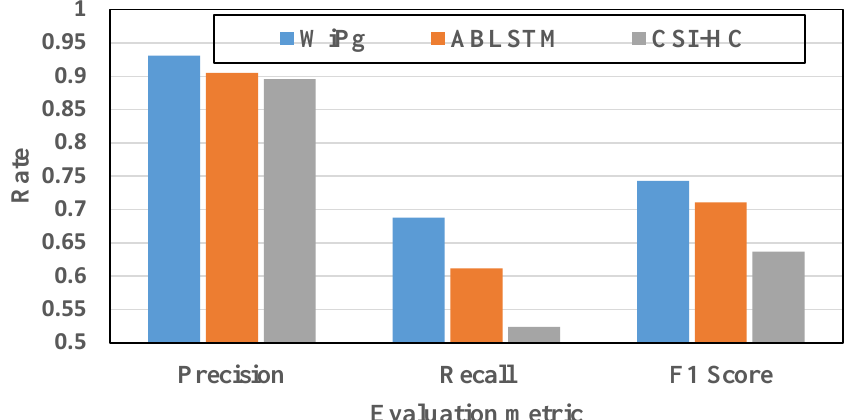
Figure 19. Comprehensive evaluation of classification performance.